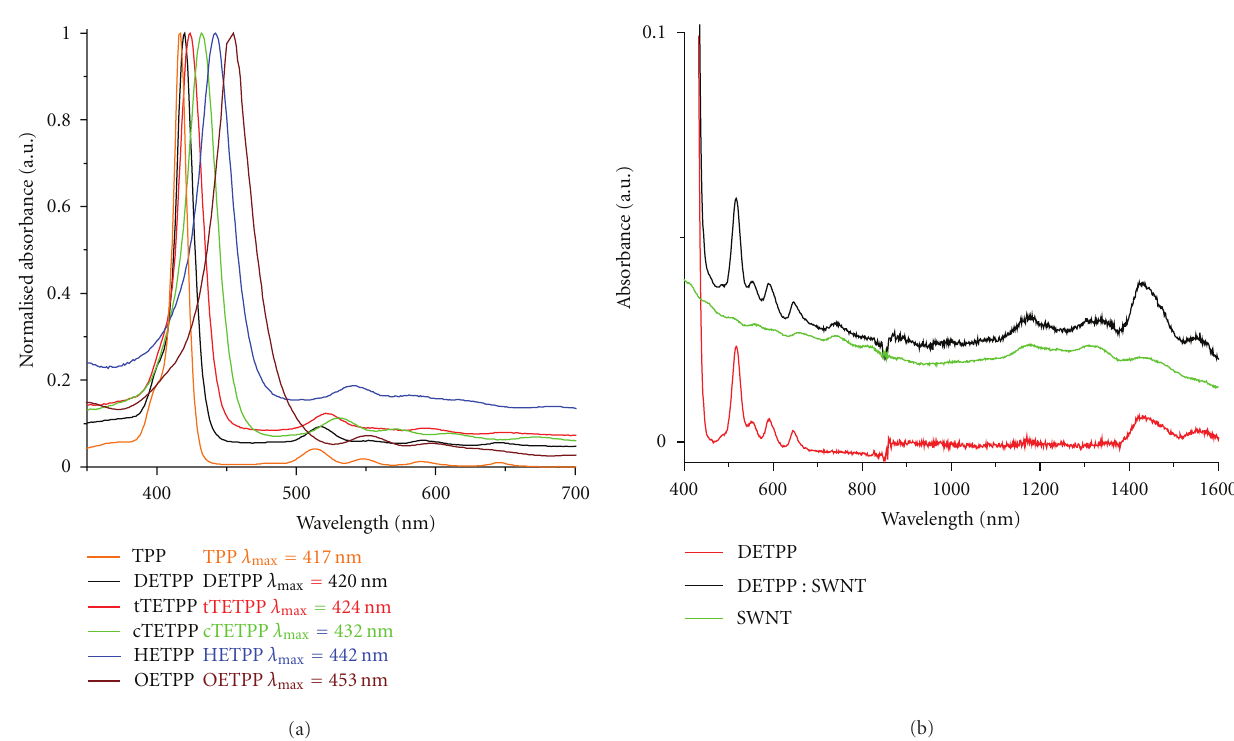
Figure 1: (a) Normalized UV-VIS absorption spectra of TPP, DETPP, tTETPP, cTETPP, HETPP, and OETPP and their (1:1) SWNT composites (0.001 mg/mL, DMF, 25 ◦ C). (b) The VIS-NIR absorption spectra of DETPP, its (1:1) SWNT composite, and a dispersion of SWNT alone in DMF show the characteristic Q Bands and Van Hove peaks and show that the absorption spectrum of the composite solution is intermediate between that of the porphyrin and the SWNT with characteristics of